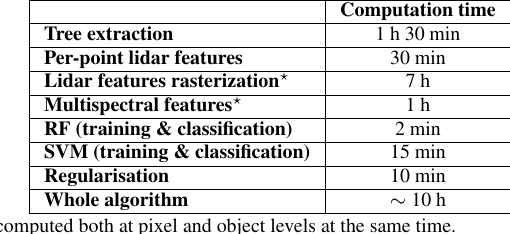
Table 12. Mean computation times (over the 8 areas) for a 1 km 2 (cid:13) zone on a Intel R Core TM i7 @ 3.40